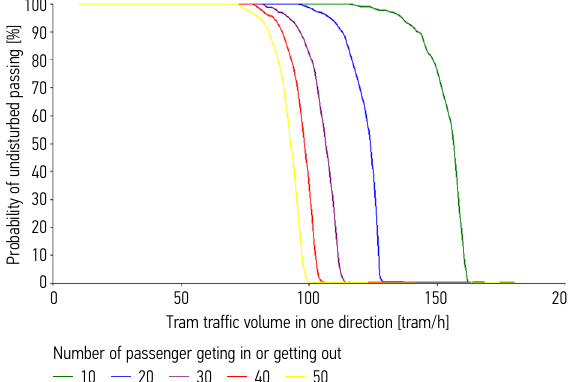
Fig. 4. Probability of undisturbed passing before standard stop